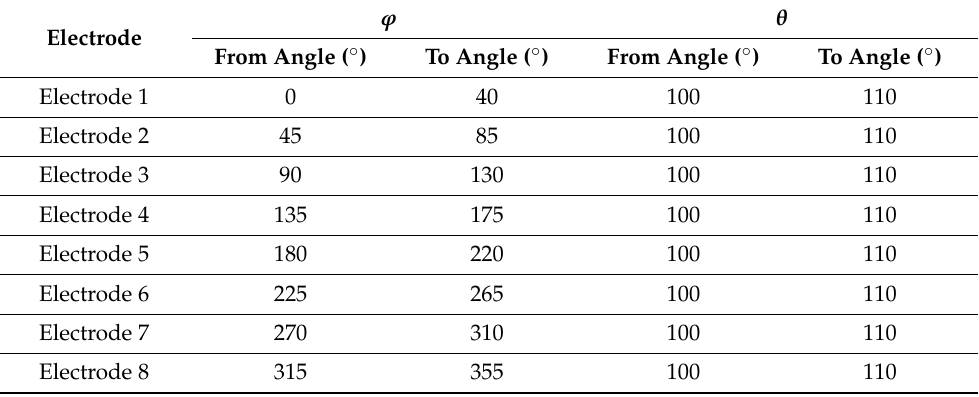
Table 2. Position of pickoffs on HRG.